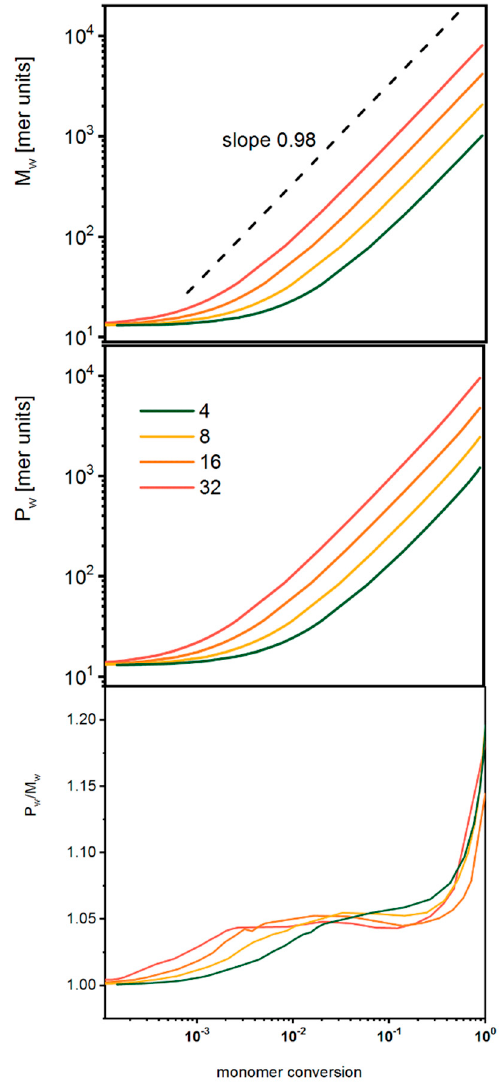
Figure 6. Number-averaged mass (upper panel), weight-averaged mass (middle panel) and dispersity (lower panel) for dendrimers as a function of the monomer conversion. The color indicates the number of macromolecules in the system (see text for details).